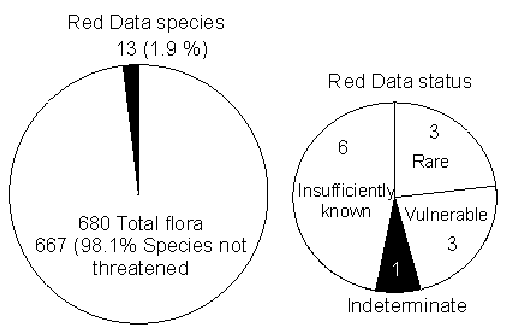
Fig. 4. Number and status of Red Data species according to Hilton-Taylor